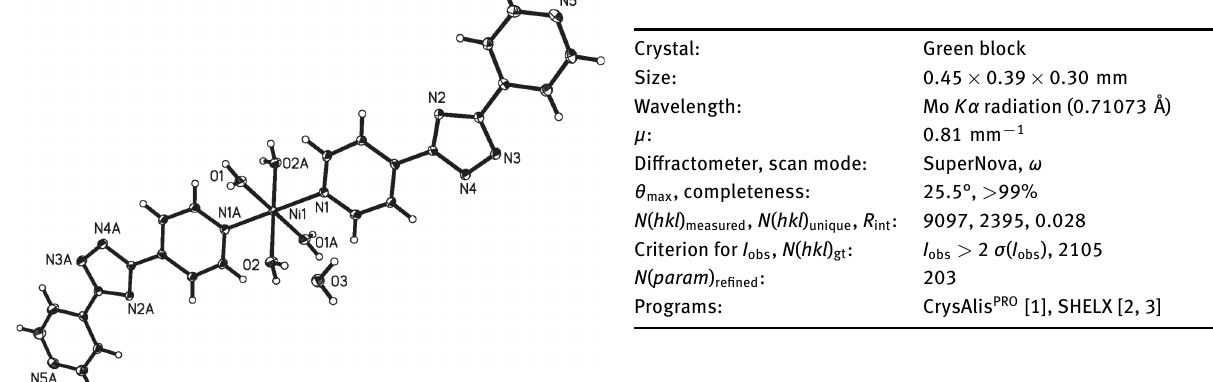
Table 1: Data collection and handling.